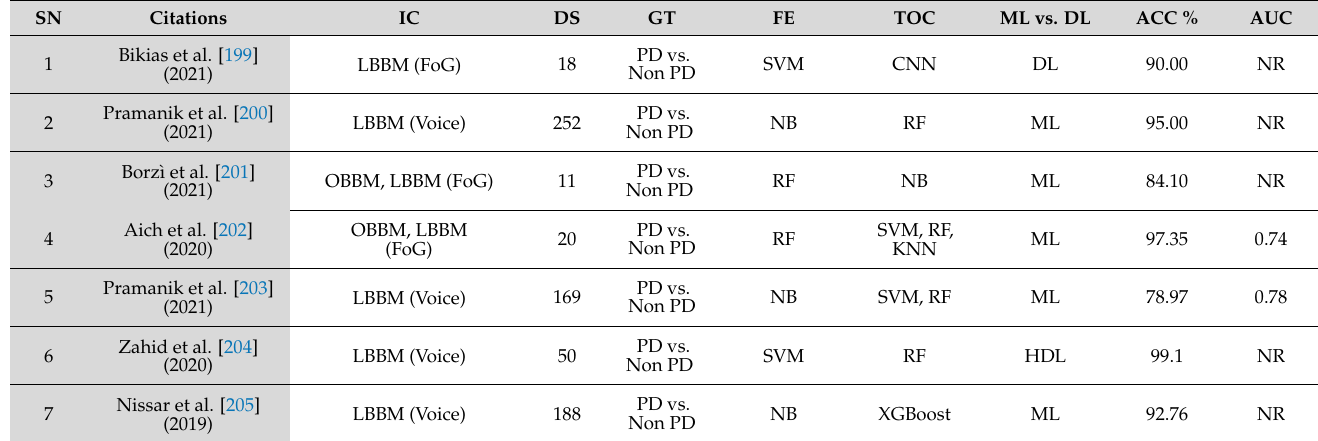
Table 5. The table shows the prediction of Parkinson’s by using